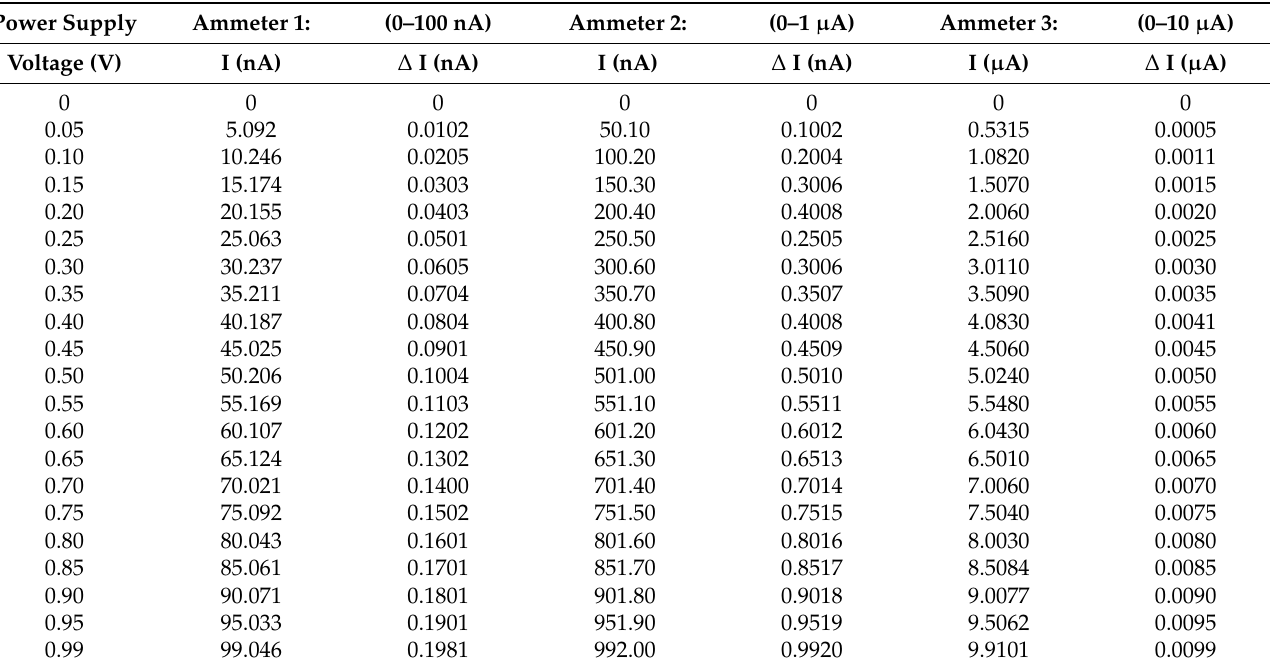
Figure 6. Experimental setup to calibrate the ammeters. Table 2. Experimental